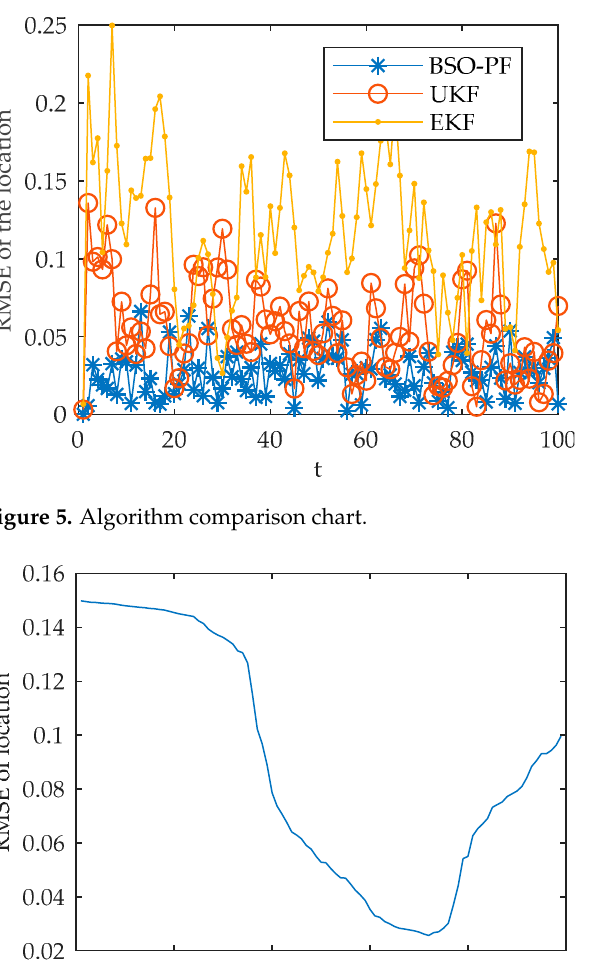
Figure 4. Target tracking trajectory graph.